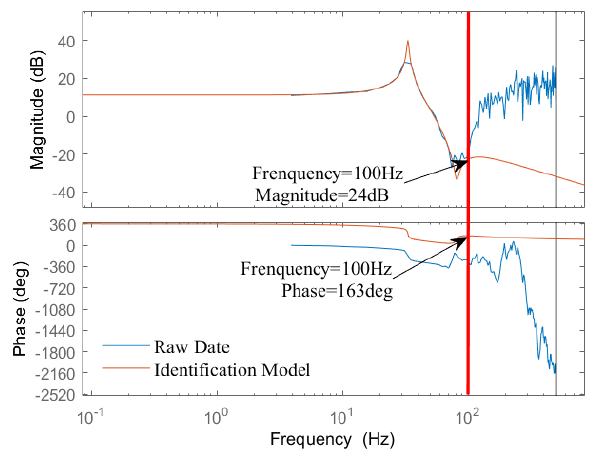
Figure 11. Comparison of Bode diagram between identification system and original system.